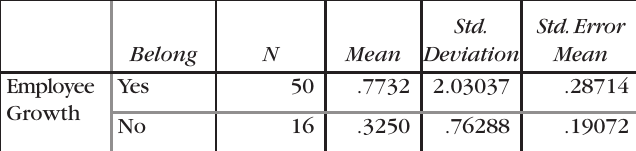
Table 8. Statistics for Average Number of